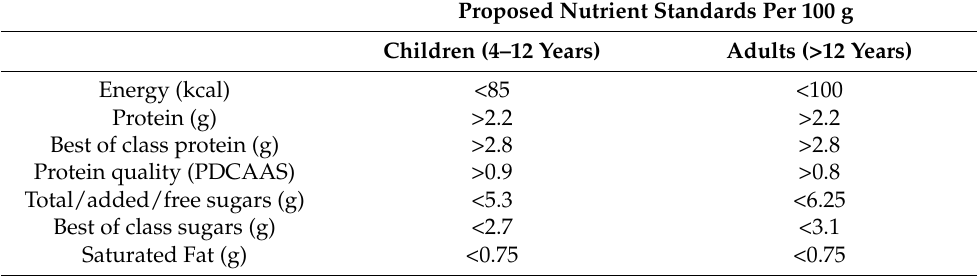
Table 2. Proposed energy and nutrient content for PB milk